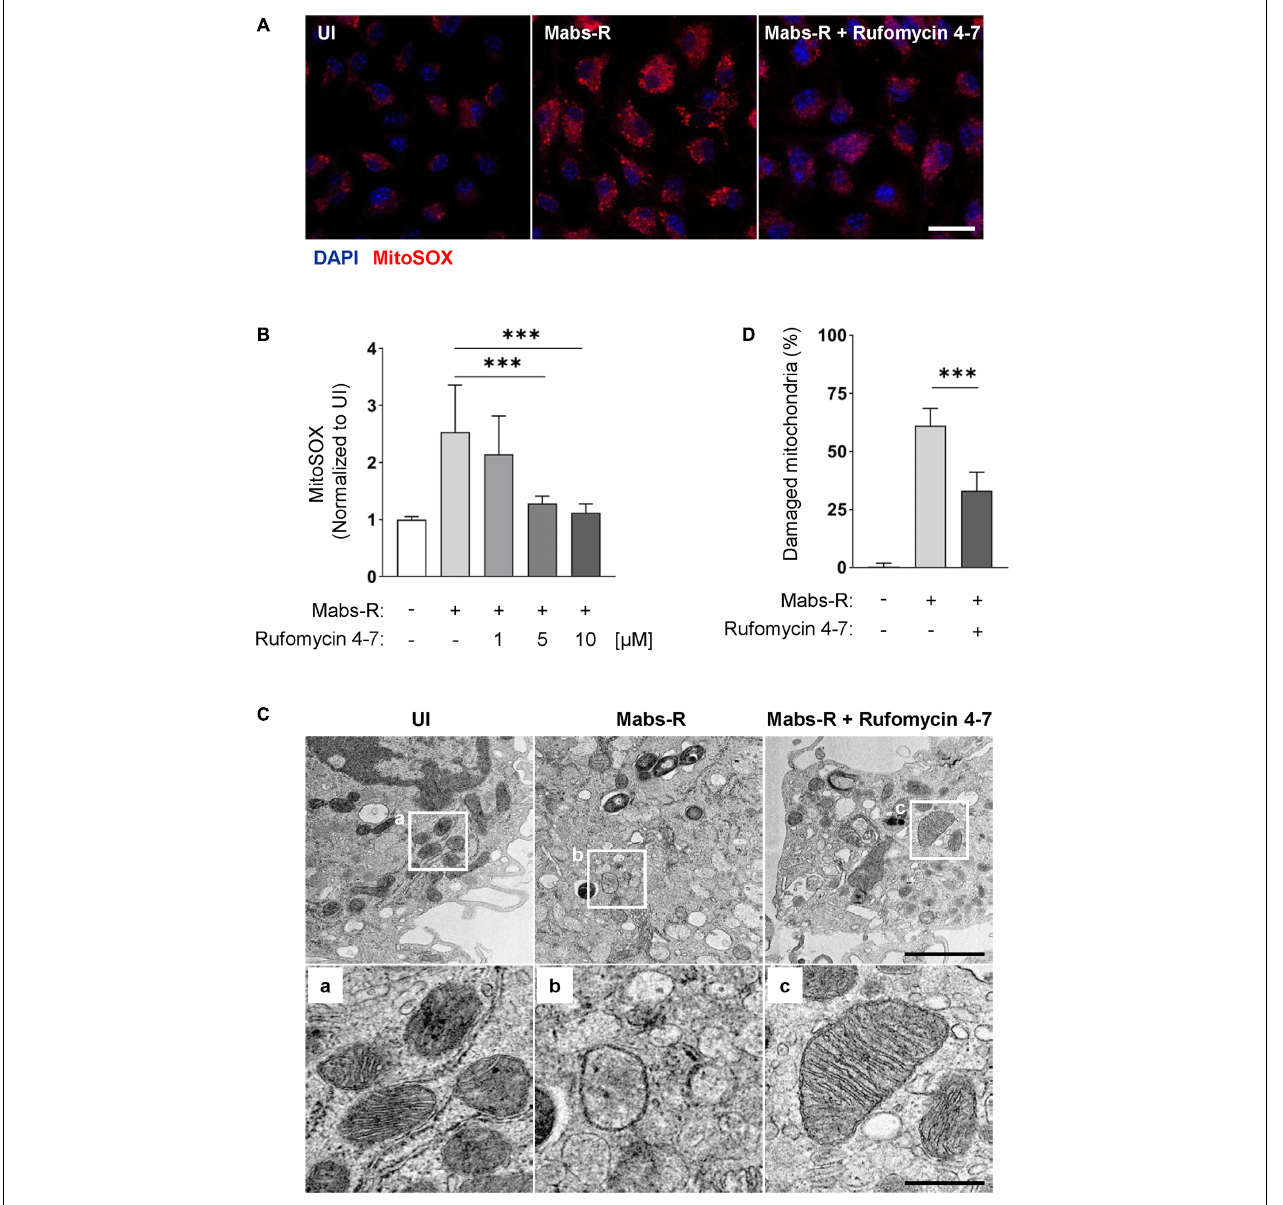
FIGURE 6 | Rufomycin 4–7 ameliorates mitochondrial damage and oxidative stress during Mabs-R infection. (A) BMDMs were infected with Mabs-R (MOI = 3) for 2 h and further cultured with Rufomycin 4–7 (1, 5, or 10 µ M) for 2 h in the fresh media. The cells were stained with MitoSOX and visualized with confocal images (scale bar: 12.5 µ m). (B) The relative intensity level of mtROS of infected BMDMs was calculated relative to UI ( n = 9 for each group; at least 80 cells per image). (C) BMDMs were infected with Mabs-R (MOI = 3) for 2 h and cultured with Rufomycin 4–7 (10 µ M) for 18 h. Cells were harvested and then subjected to TEM analysis. Representative images and their magnified images (a–c) from each group are shown (scale bar: 500 nm or 1 µ m). (D) The ratio of damaged/total mitochondria was manually calculated from at least nine EM images. ∗∗∗ p < 0.001. Statistical analysis was determined with one-way ANOVA (B,D) and presented as means ± SD from at least three independent experiments performed in triplicate. UI,